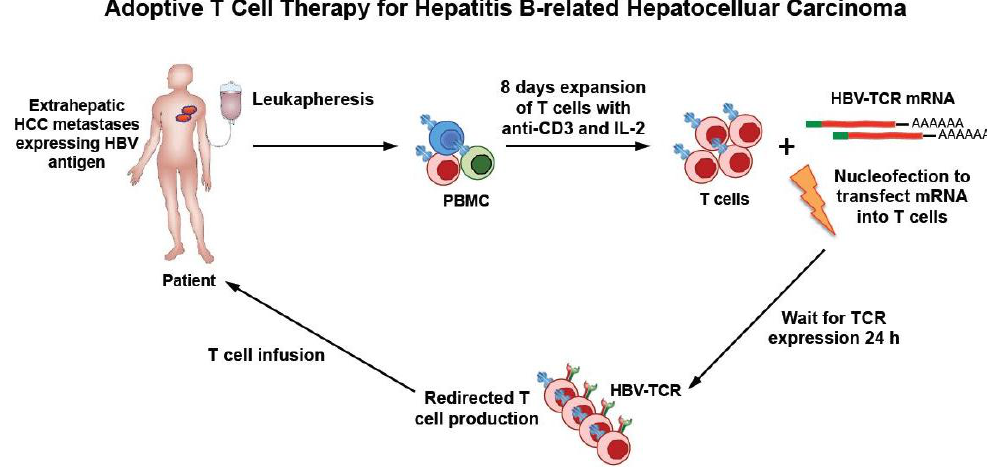
Figure 1. A schematic illustrating production of HBV-TCR redirected T cells using messenger RNA electroporation, followed by adoptive transfer in a patient with HBV-related HCC. A patient’s own T cells can be expanded in vitro for eight days using soluble anti-CD3 antibody and high dose IL-2. The primary T cells are electroporated with mRNA encoding HBV-specific TCR to transiently redirect their specificity towards HBV. At 24 h post-electroporation, the T cells are analyzed for TCR expression using HLA class I pentamers specific for the introduced TCR, and the functionality of the redirected T cells are assessed (by their ability to produce IFN-g and degranulate upon antigen-specific stimulation). The redirected T cells can be re-infused into the patient, whereby they will recognize and lyse HCC cells expressing HBV antigen within 3–4 days and then their specificity is lost.